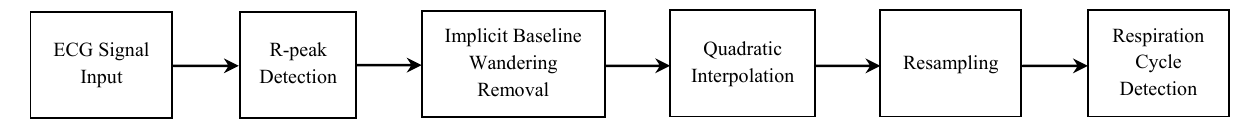
Figure 2. Block diagram of the implemented EDR